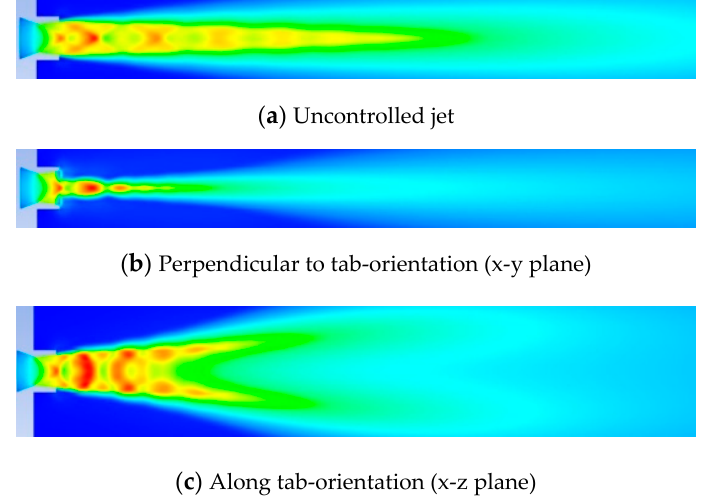
Figure 26. Mach contours of uncontrolled and controlled jets at NPR 6 (marginal underexpansion).